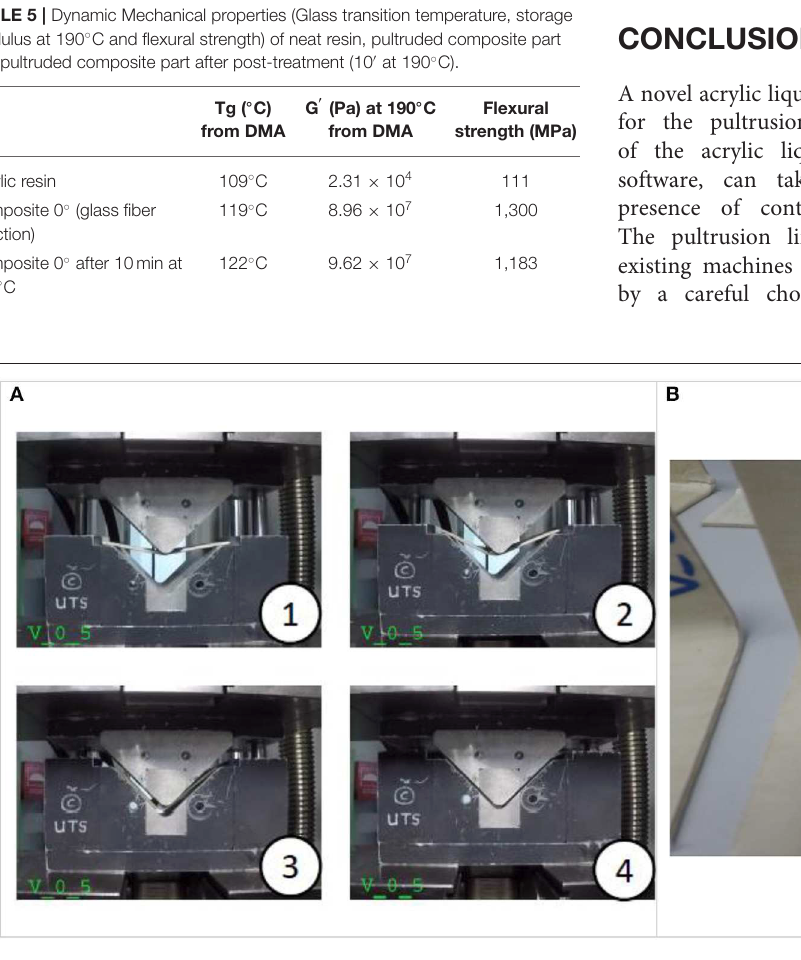
FIGURE 9 | (A) Experimental set-up of thermoforming trials and (B) Thermoformed pultruded ELIUM ® UD profile (Univ. Siegen).